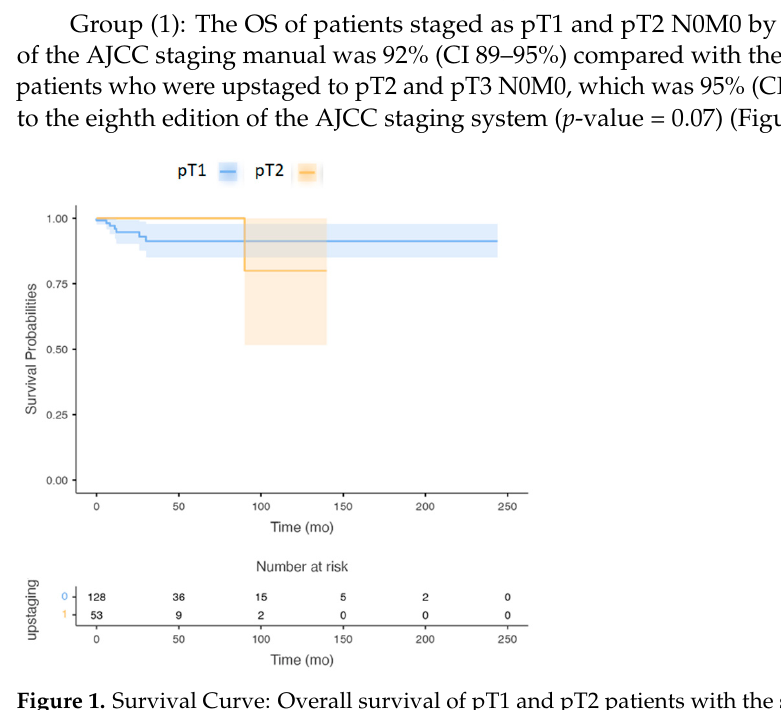
Figure 2. Survival Curve: The 5-year DSS of patients upstaged to pT3 (eighth AJCC staging system) from pT1, pT2N0M0 (seventh AJCC staging system). ( p -value > 0.05).